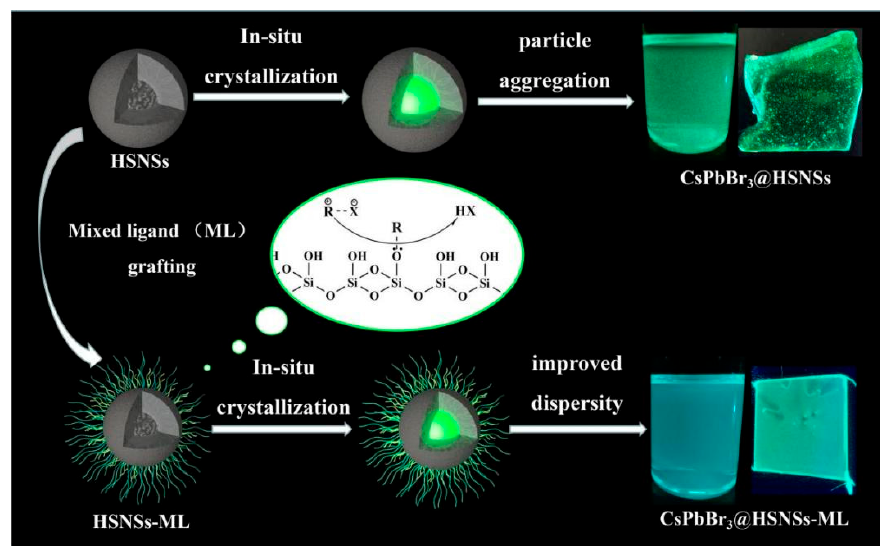
Figure 1. Schematic depiction of two pathways to construct template-assisted CsPbBr 3 nanoparticles and the comparison of their solution properties in cyclohexane.